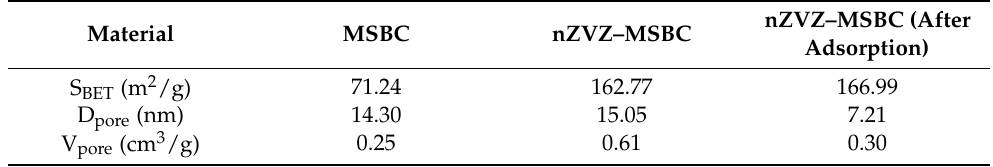
Table 1. Characteristics of the pore structures of adsorption